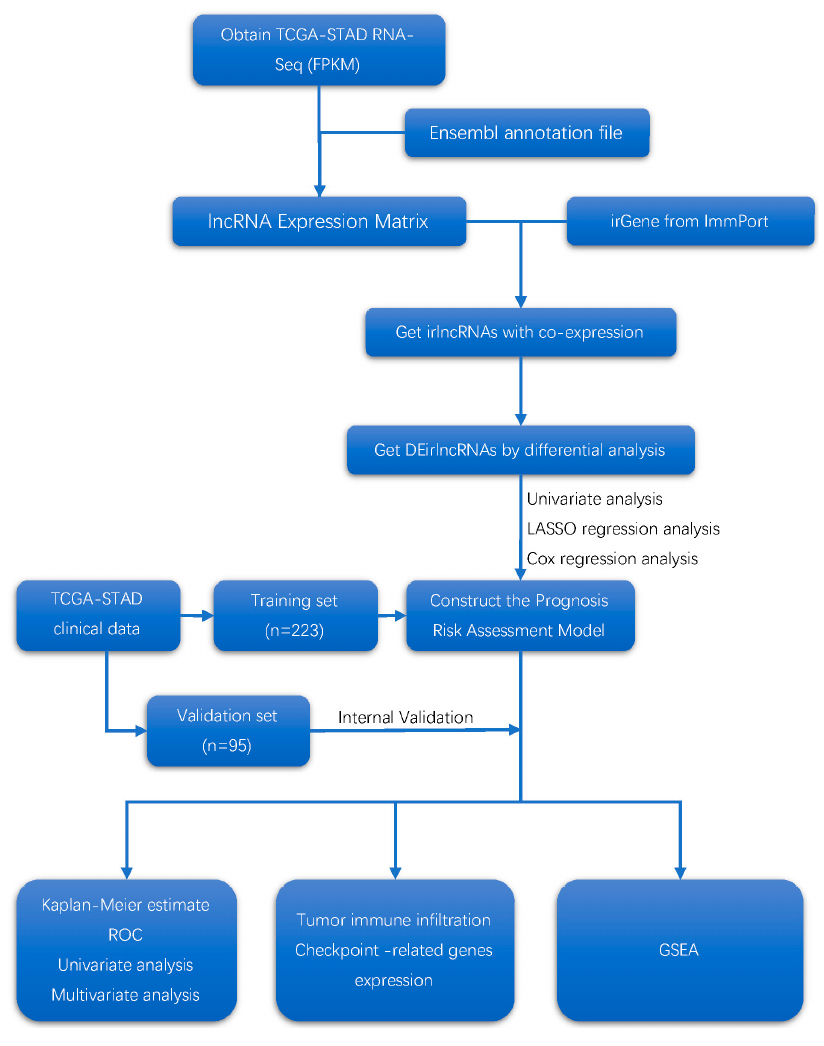
Figure 1. Flow diagram of the study.